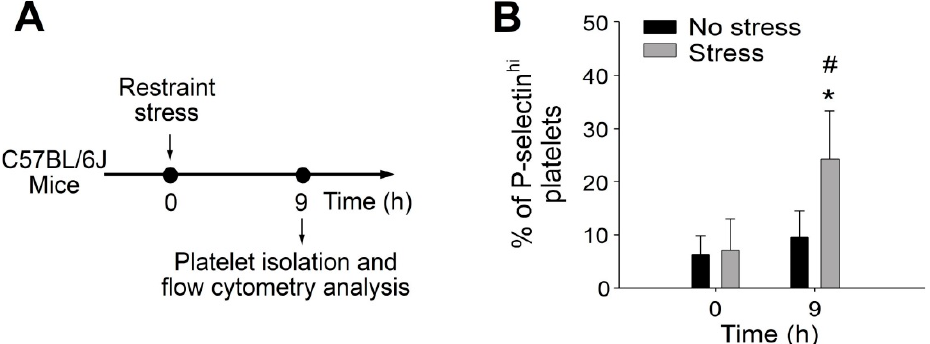
Figure 1. Percentage of circulating P-selectin hi platelets was up-regulated after restraint stress in mice. ( A ) Experiment outline of restraint stress mouse model and platelet analysis. ( B ) Percentage of platelets expressing high surface P-selectin (P-selectin hi ) levels of mice with or without restraint stress at 0 and 9 h was detected by flow cytometry. Error bars show standard deviation; * p < 0.05, vs. 0 h groups; # p < 0.05, vs. no stress groups. n = 6 (three experiments with total six mice per group).